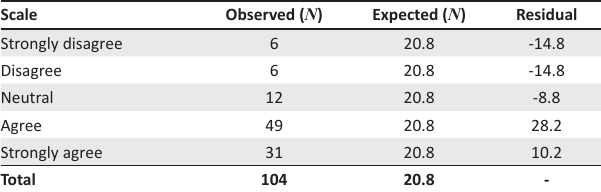
TABLE 2: H0: There is no significant relationship between the Lagos State Employment Trust Fund sponsored vocational training for Information